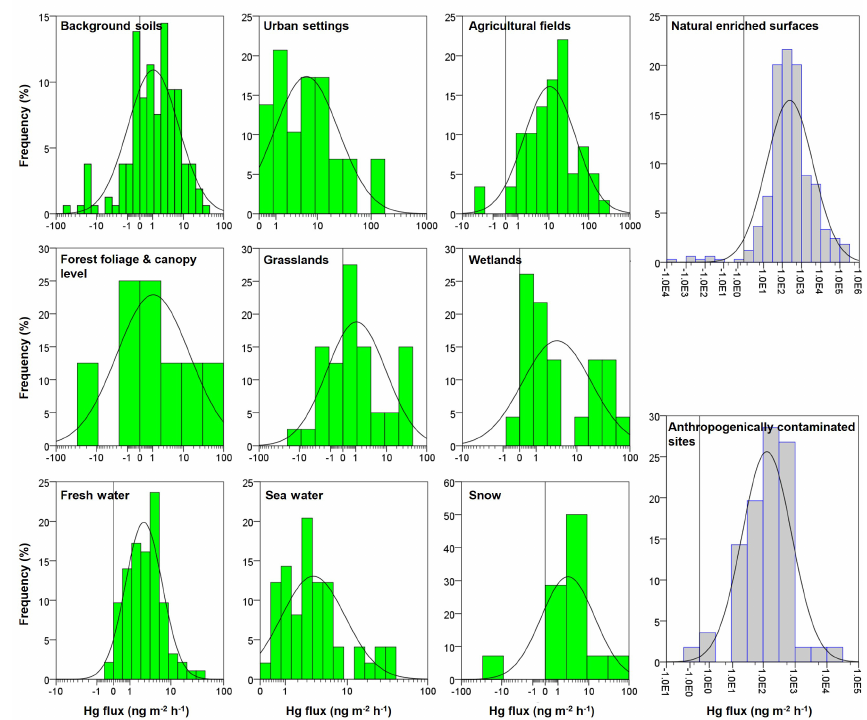
Figure 7. Histograms of Hg 0 flux frequency distribution obtained from various Earth surfaces. (Data source: Table